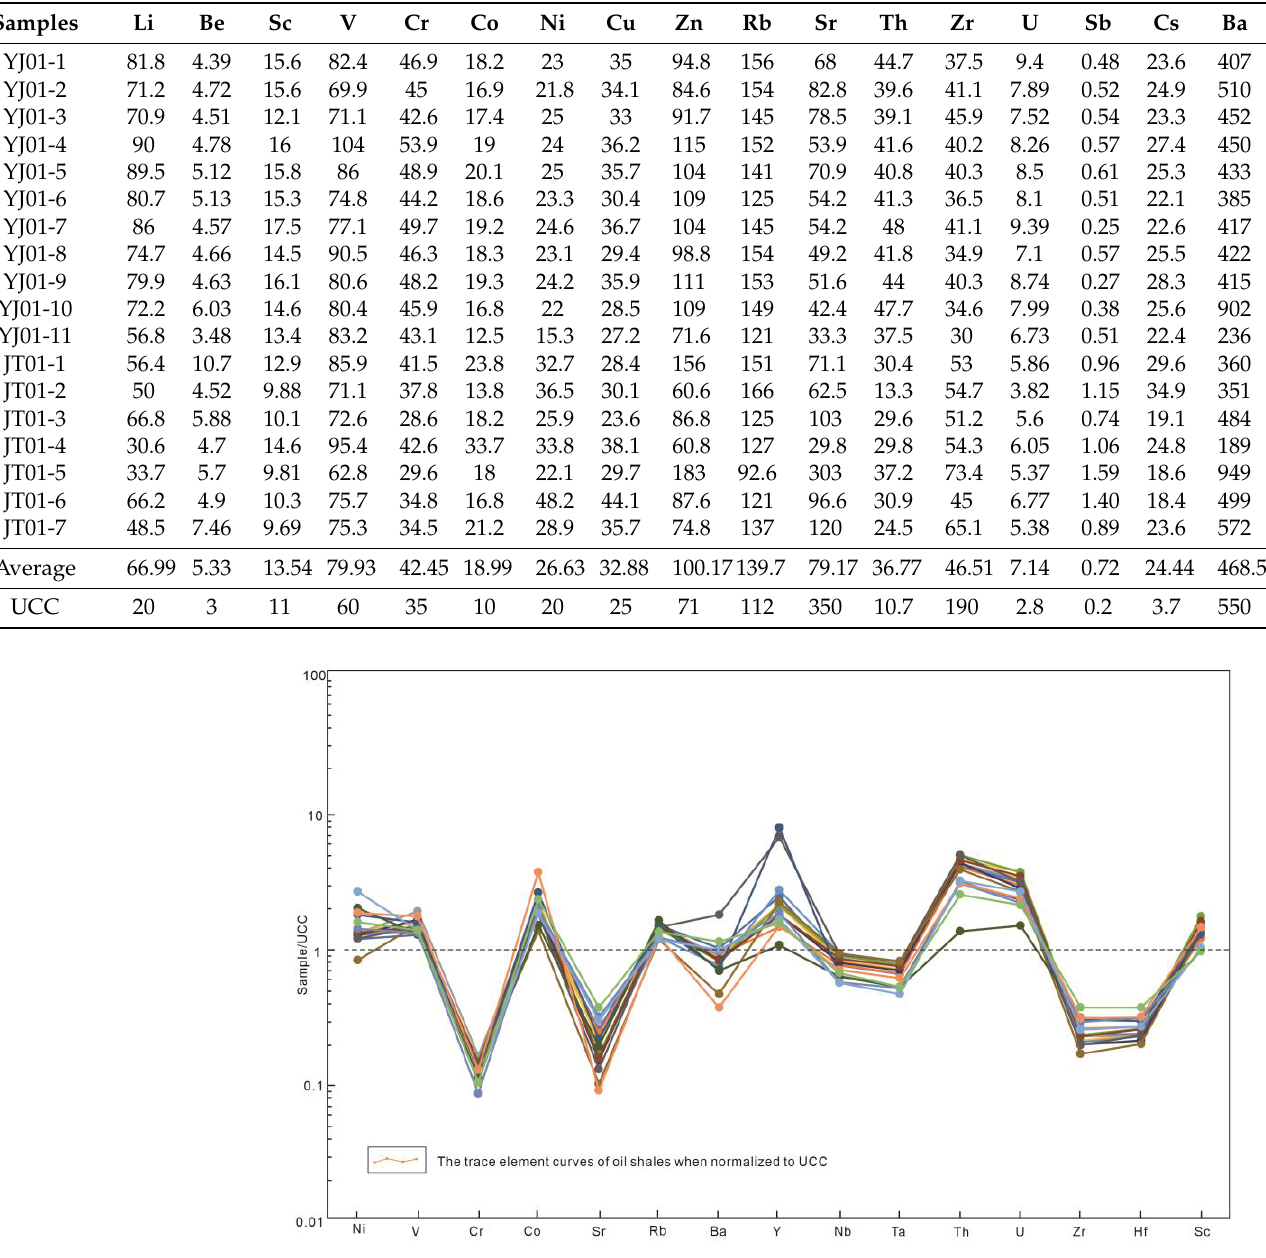
Figure 6. Trace elements UCC-normalized patterns for the samples. Table 4. Rare earth elements ( µ g/g) in oil shale of Youganwo Formation in Maoming